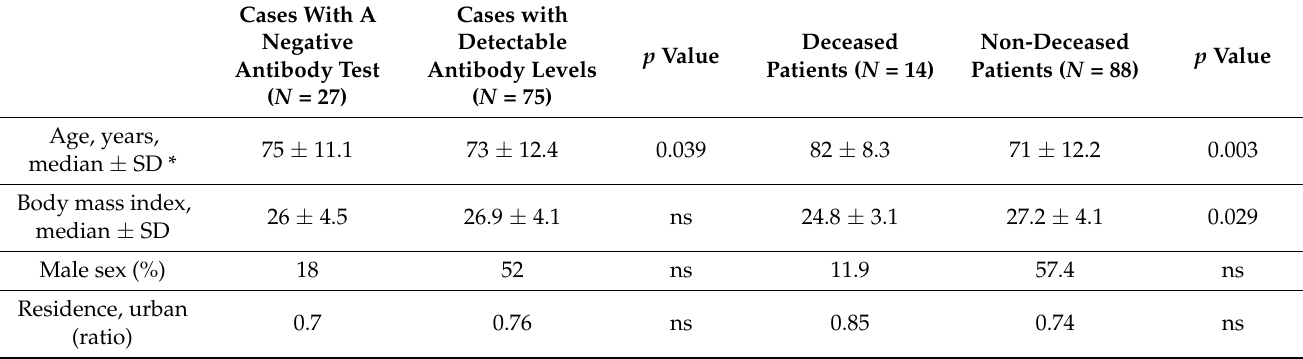
Table 2. Baseline characteristics of the study population ( N =